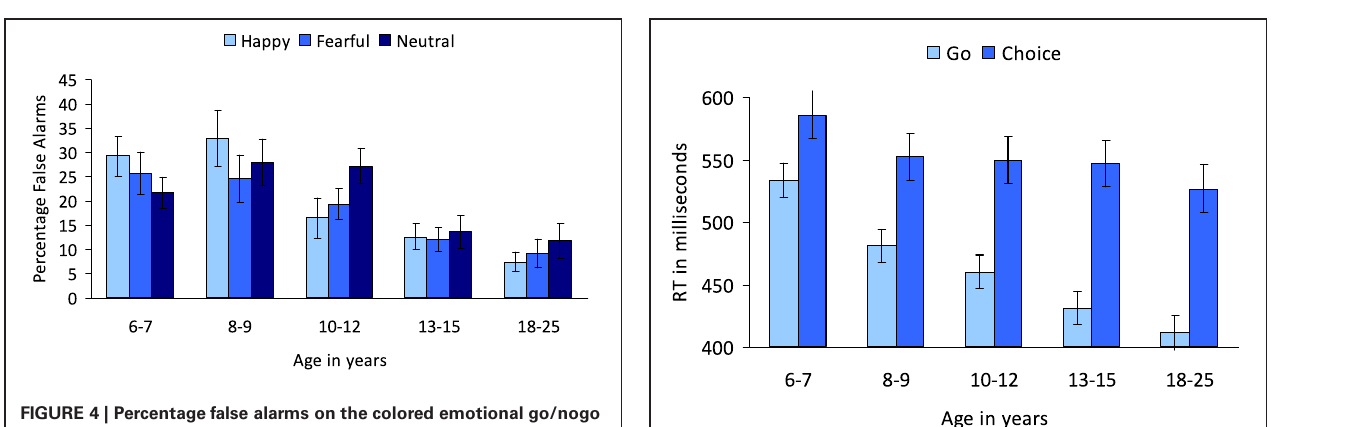
happy, and fearful) repeated measures ANOVA was